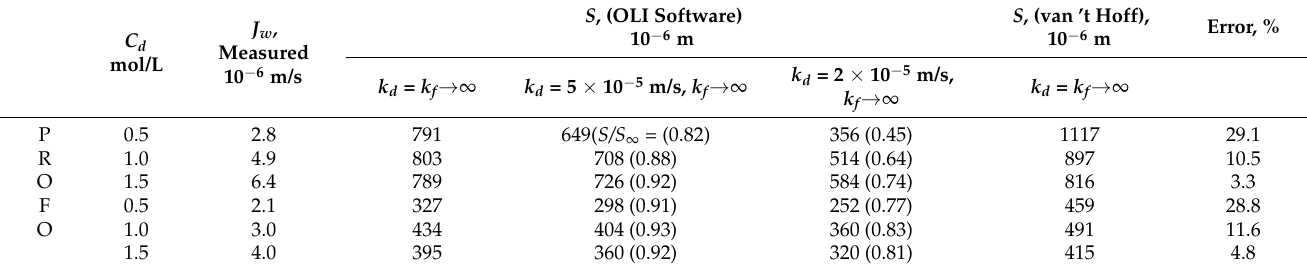
Table 5. Application of measured data of Manickam and McCutcheon [40], for illustration of the effect of the external transfer coefficient on the predicted values of the structural parameter. The first two columns contain data published in [40]. The measured water flux data is shown to one decimal point in order to reflect that the reading error can reach 10% [40]. The third column ( k d = k f → ∞ ) is data published in [40]. The fourth and fifth columns are calculations conducted in